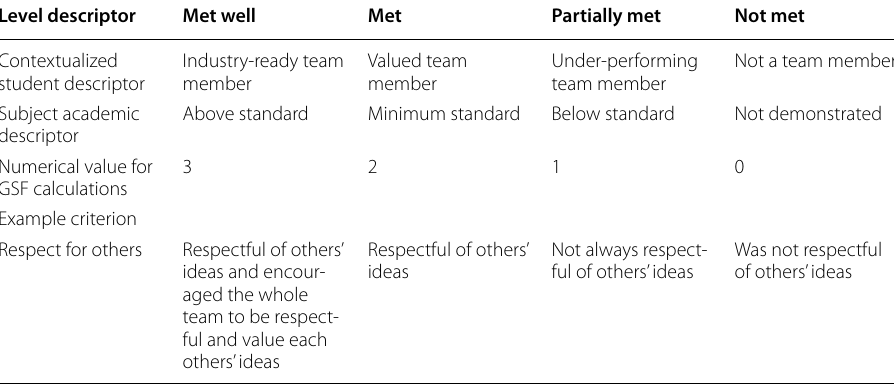
Table 1 Contextualisation of rubric levels for students and academics, with an example criterion Level